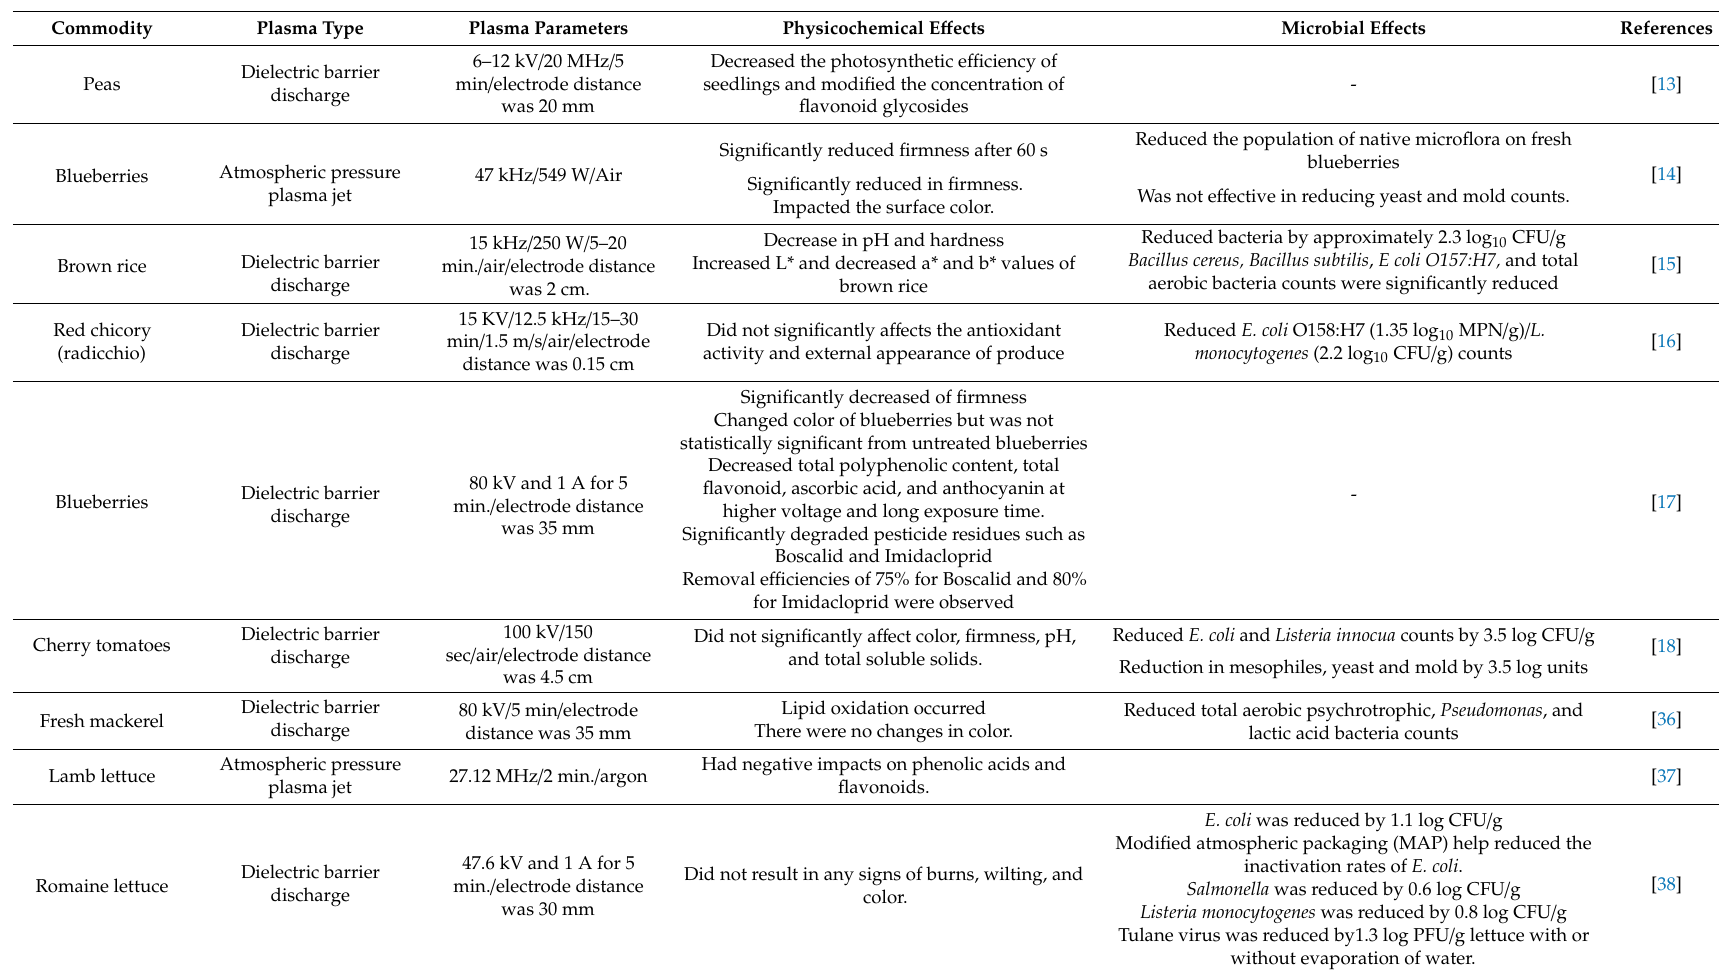
Table 1. Summary of the e ff ects of cold plasma (CP) treatment on food